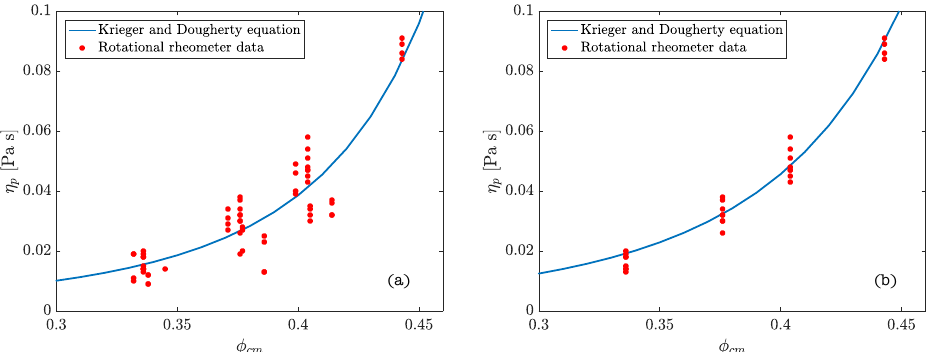
Figure 3. Adjustment curves for the experimental measures to the Krieger–Dougherty equation: ( a ) all the pastes designed; ( b ) CEM I 52.5 N-SR.